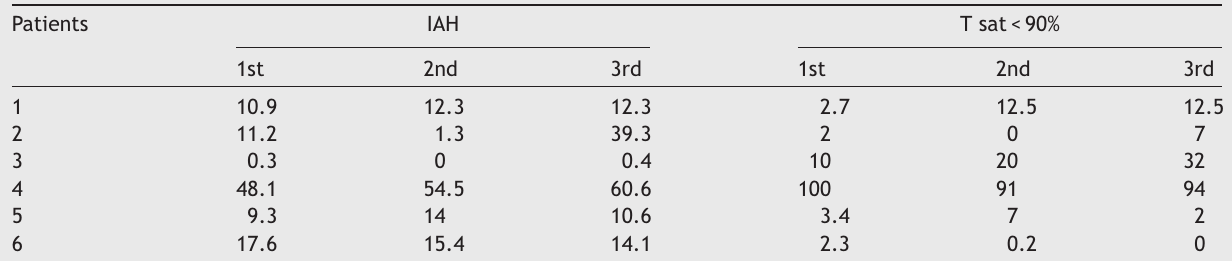
Apnea---hypopnea indexes (IAH) and time of sleep with oxygen saturation inferior to 90%.